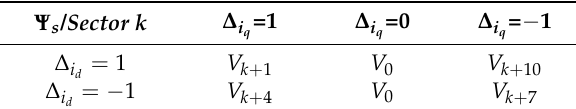
Table 3. The switching table of the proposed scheme. Ψ s / Sector